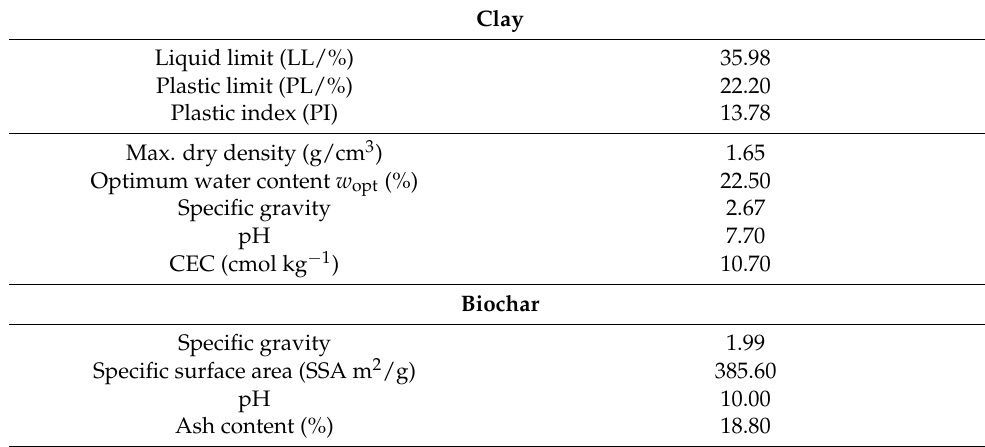
Table 1. Basic physical and chemical indexes of clay and biochar.